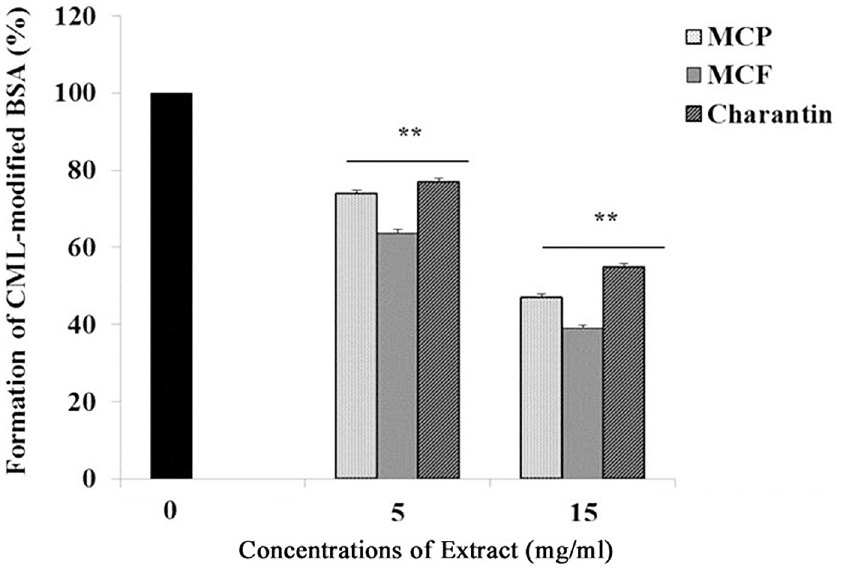
Fig 2. Effects of different concentrations of MCP, MCF and charantin on CML formation. The bar graph shows the effect of different concentrations (5 and 15 mg/ml) of the MCP, MCF and charantin extracts on production of CML following glycoxidation of BSA (300 mg) in 0.2 M phosphate buffer, pH 7.8 at 37°C over a period of 24-hours. The positive control was the amount of CML-modified BSA produced in the absence of extracts. The results are presented as mean ± SD (n = 3), ** : p < 0.01 vs